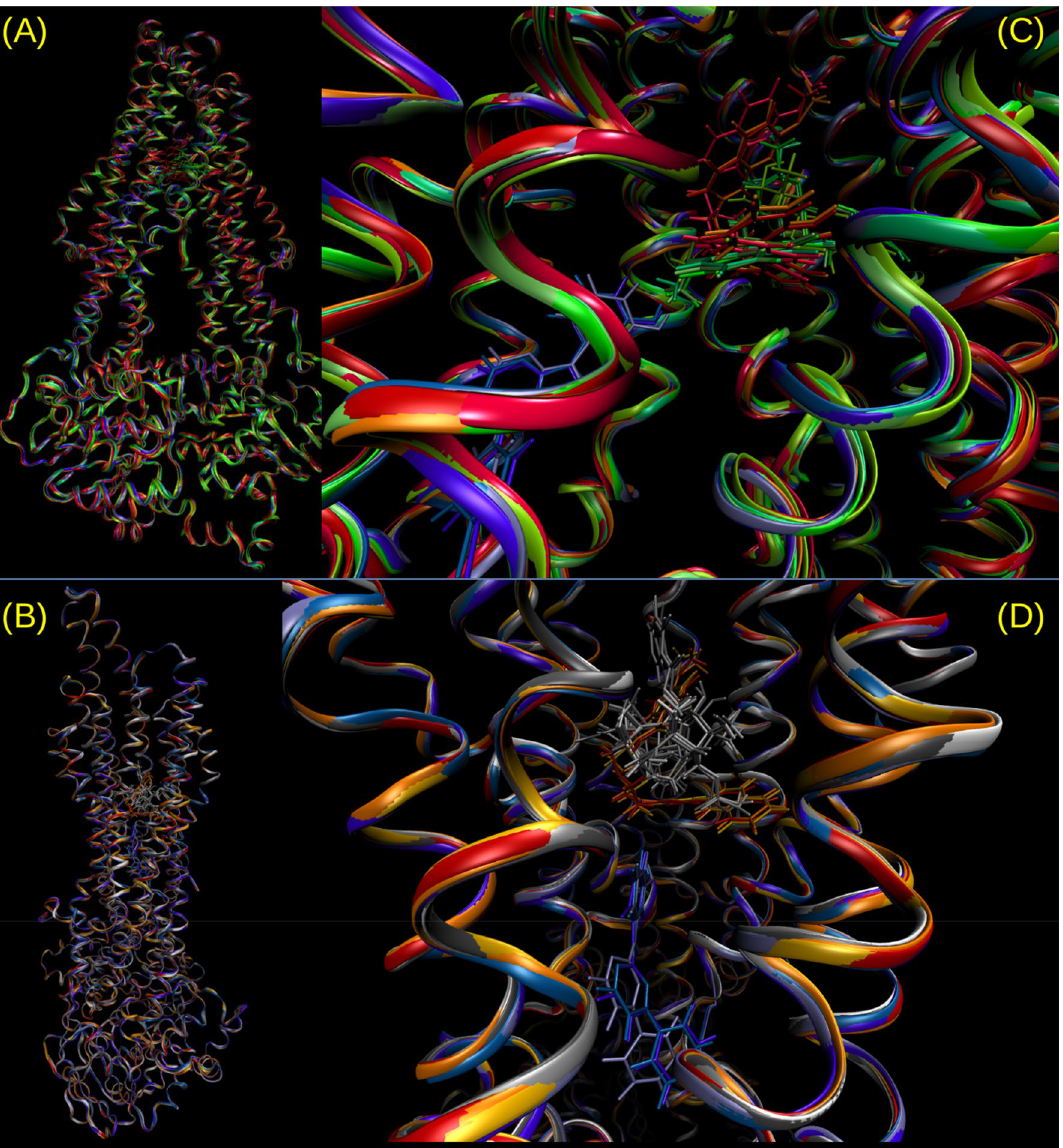
(red tones), doxorubicin (green tones) and compound 8 (blue tones). ( D ) The same for compounds 7b and 8 and for Taxol (gray